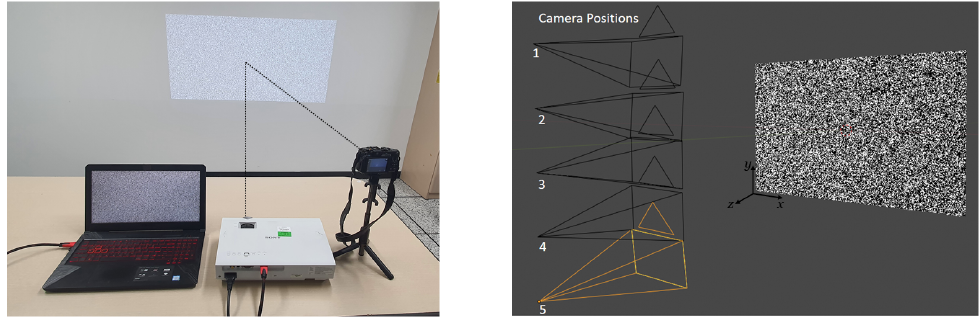
Figure 2. Experimental setup for image acquisition in ( left ) real ( right ) virtual